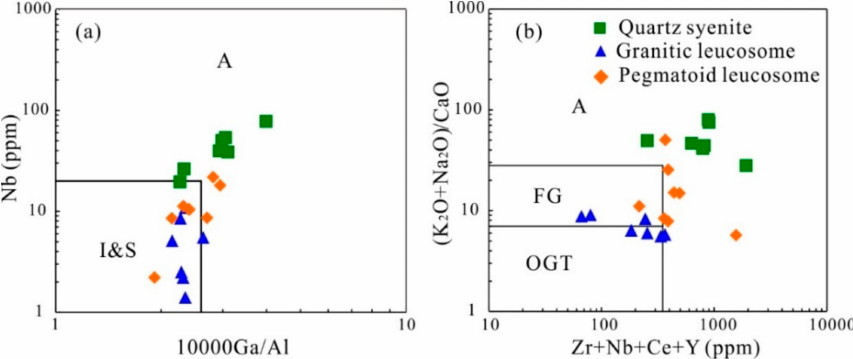
Figure 11. Discrimination of granitoids genetic types (modified from [81]). FG = fractionated M-, I- and S-type granites; OGT—unfractionated M-, I- and S-type granites.